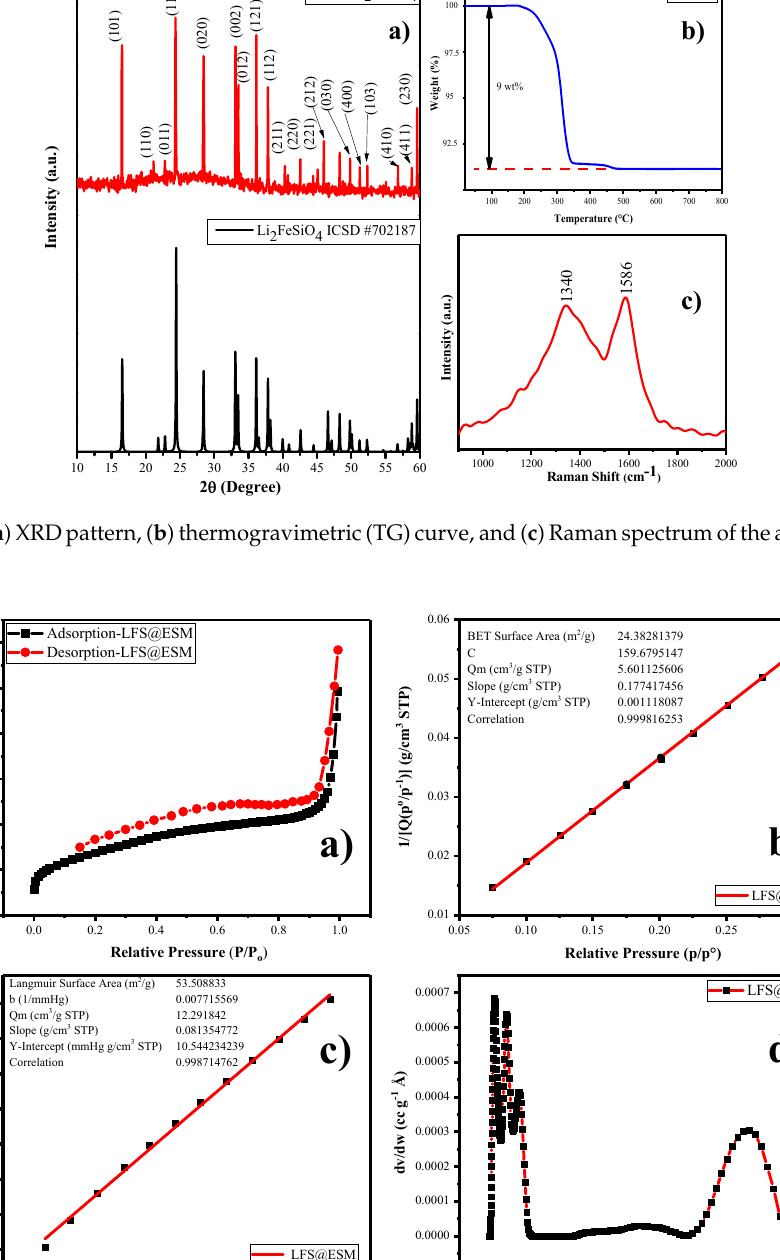
Figure 2. ( a ) XRD pattern, ( b ) thermogravimetric (TG) curve, and ( c ) Raman spectrum of the as ‐ prepared LFS@ESM.